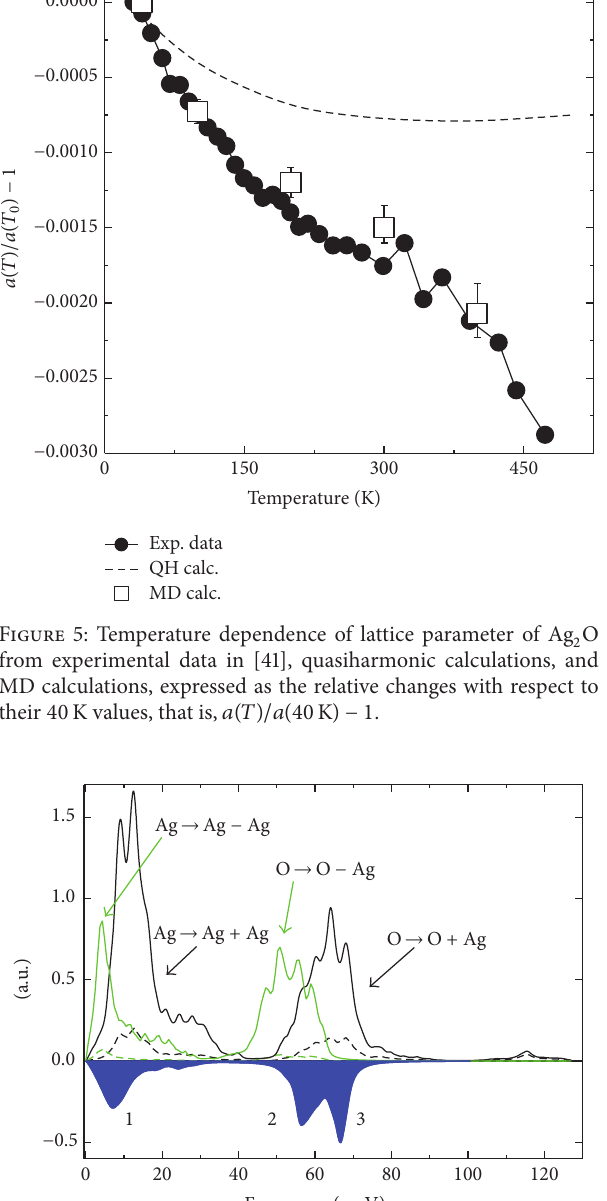
Figure 4. On the other hand, the 𝐸 𝑔 and 𝐴 1𝑔 modes are not broadened at low temperatures because their frequencies are at low values of the TDOS. The study on the structures of phonon-phonon interaction channels successfully marks the “hot” downconversion decay activities even at low tem- perature limit and accounts for the significant difference of linewidths between 𝐵 2𝑔 and the other two Raman modes at low temperatures.